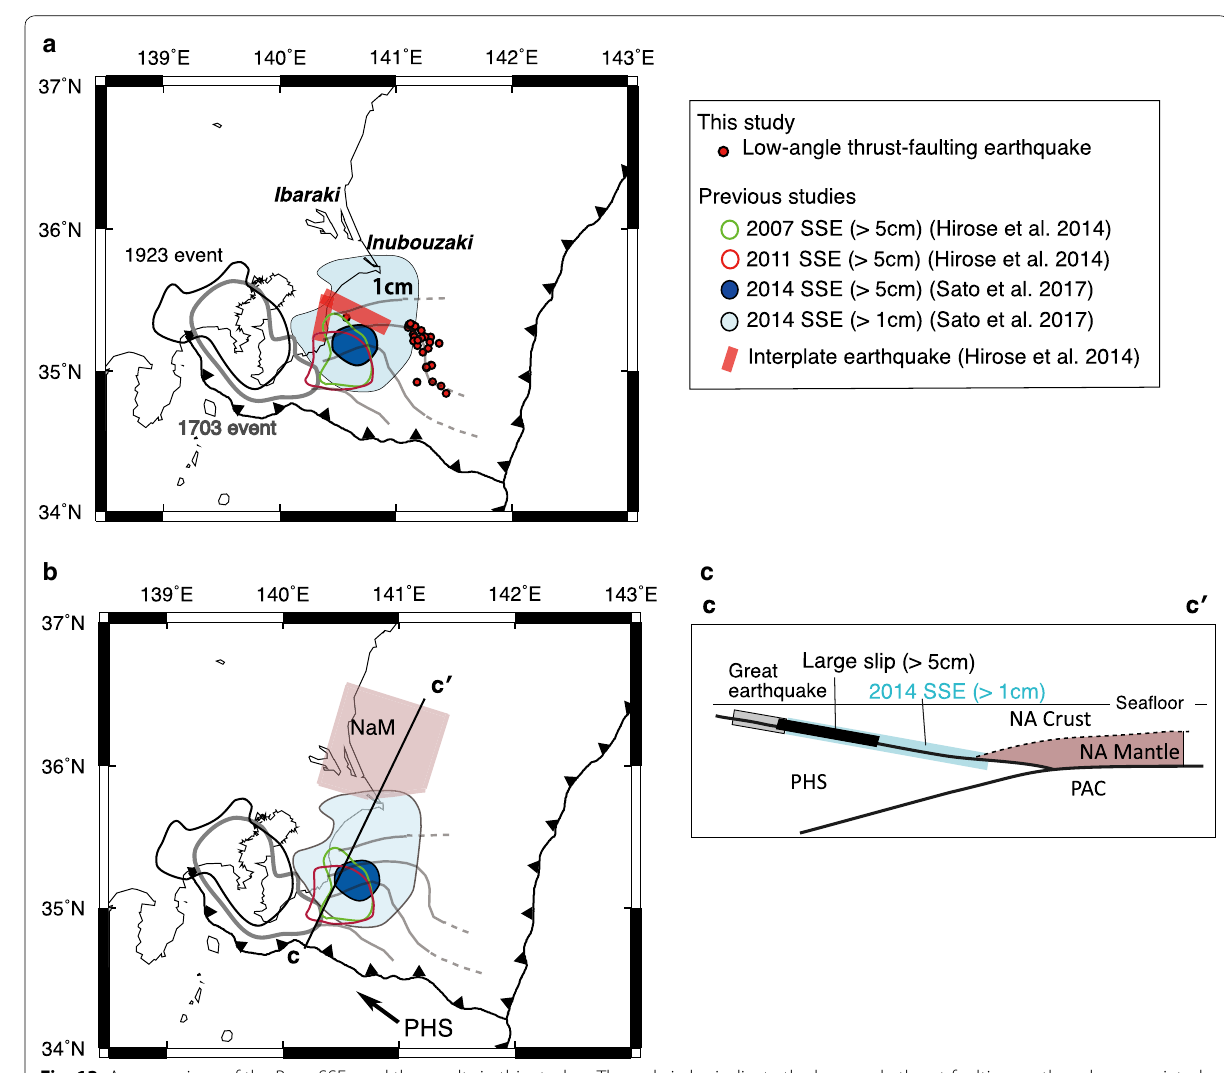
Fig. 13 A comparison of the Boso SSEs and the results in this study. a The red circles indicate the low-angle thrust-faulting earthquakes associated with PHS. The red and green lines indicate the areas with slip larger than 5 cm for SSEs in 2007 and 2011, respectively (Hirose et al. 2014). The light blue and blue regions show slip areas larger than 1 cm and 5 cm, respectively, for the SSEs in 2014 (Sato et al. 2017). The orange boxes indicate areas where swarms of interplate earthquakes occurred (Hirose et al. 2014). The bold gray and thin black lines indicate the approximate source areas of the Kanto earthquakes (Fig. 1). The gray solid and broken lines show the iso-depth contours of the upper boundary of the PHS estimated in this study. b The slip area of SSEs with the distribution of the mantle part of the NA. The magenta area shows the mantle part of the NA. c Schematic view of the comparison between the SSE area and the NA mantle along line c–c ′ in panel